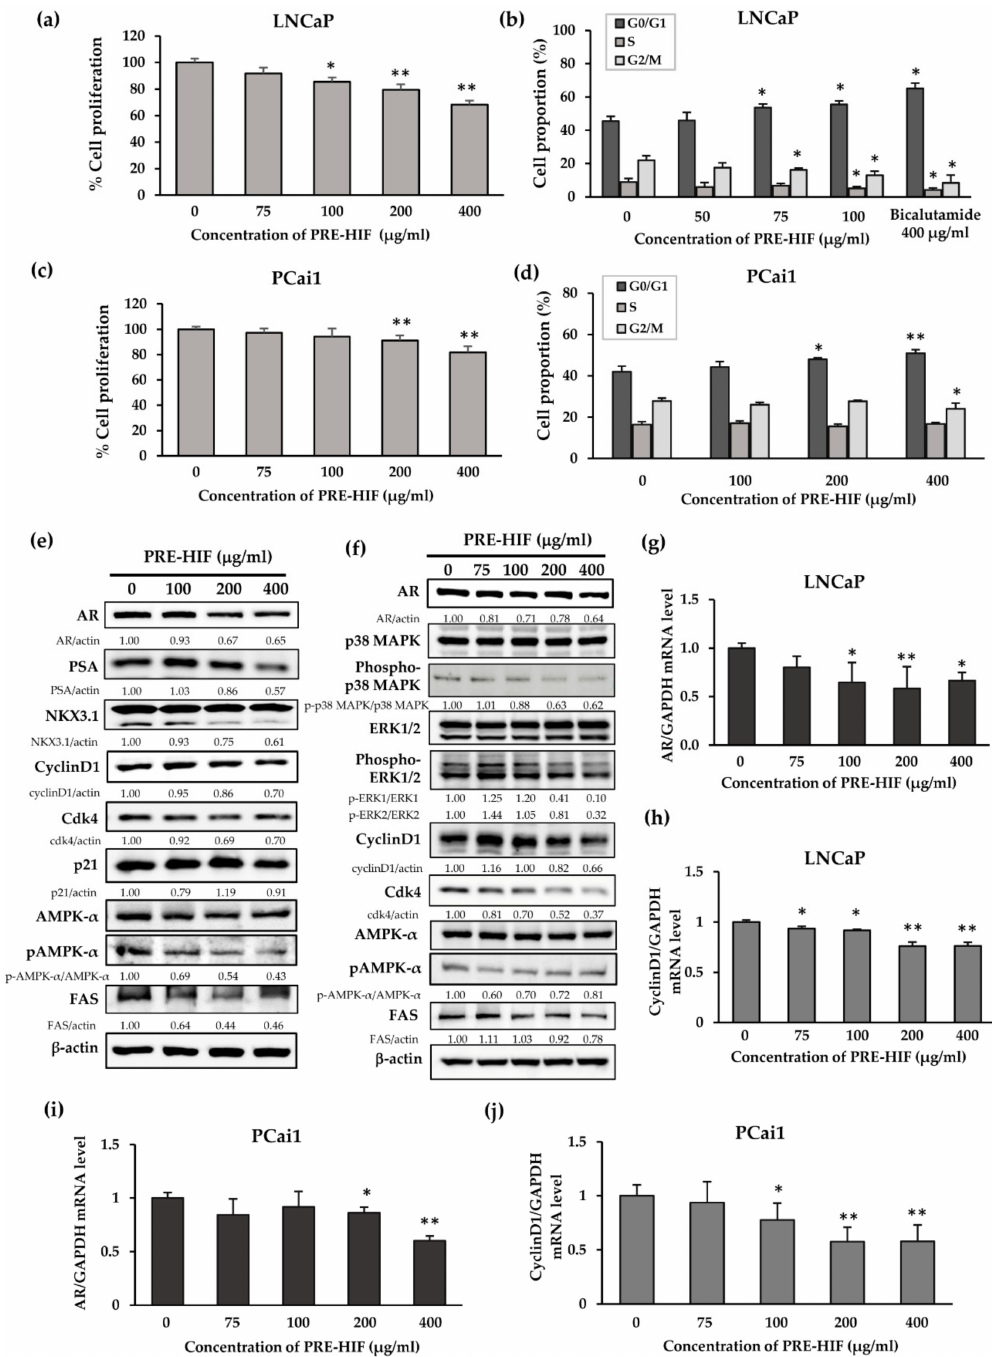
Figure 6. E ff ects of PRE-HIF on prostate cancer cell lines. (a) Cell proliferation of LNCaP and (c) PCai1 cells treated with various concentrations of PRE-HIF for 72 h. (b) E ff ects on the cell cycle of LNCaP and (d) PCai1 cells treated with various concentrations of PRE-HIF for 72 h. (e) Immunoblots of protein lysates from PRE-HIF treated LNCaP and (f) PCai1 cells (72 h) were probed with antibodies against proteins related to cell growth and metabolism. At 48 h of PRE-HIF incubation, androgen receptor (AR), and cyclin D1 mRNA levels in LNCaP (g, h) and PCai1 (i, j) cells were analyzed by quantitative real-time (RT)–PCR. All data in bar charts are shown as the mean ± standard deviation (SD) of three independent experiments. * p < 0.05; ** p < 0.01 compared to control. PRE-HIF, hexane insoluble fraction of purple rice ethanolic